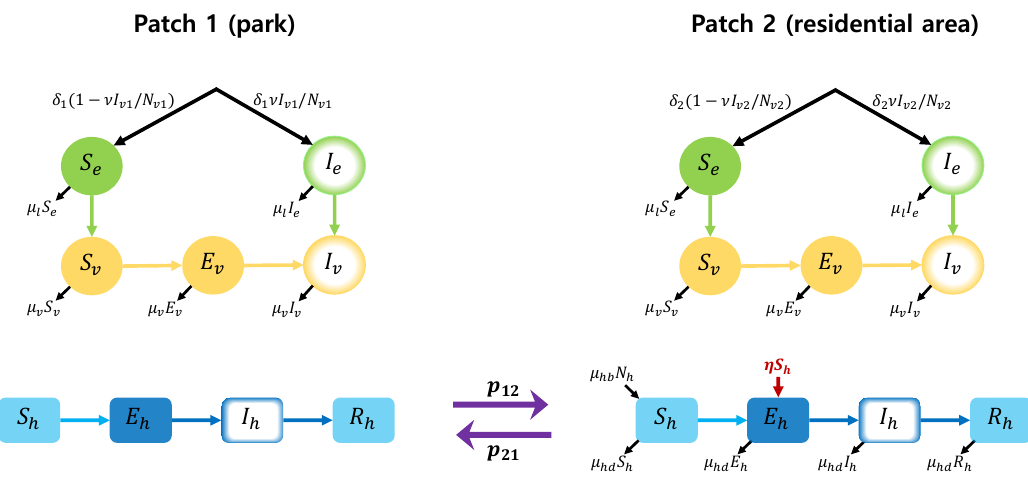
Figure 1. Two-patch dengue transmission